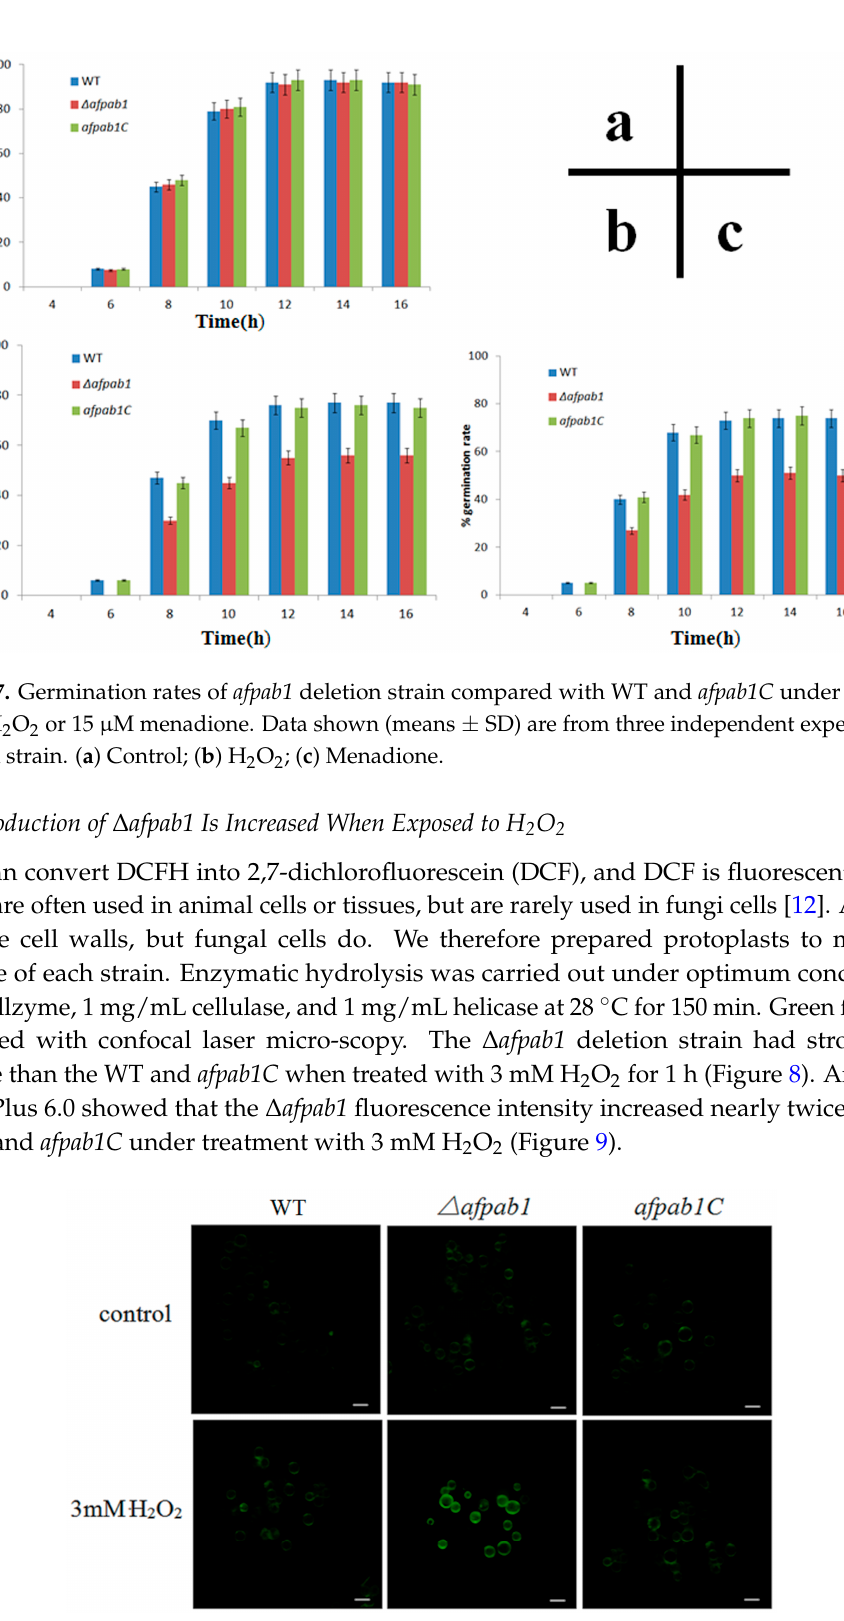
Figure 8. DCFH-DA staining was used to determine the ROS levels in the protoplasts treated with 3 mM H 2 O 2 for 1 h . The conidia were observed using fluorescence microscopy to determine the ROS 3 mM H 2 O 2 for 1 h. The conidia were observed using fluorescence microscopy to determine the ROS levels; Control group without H 2 O 2 . Bar, 10 µm. levels; Control group without H 2 O 2 . Bar, 10 µ